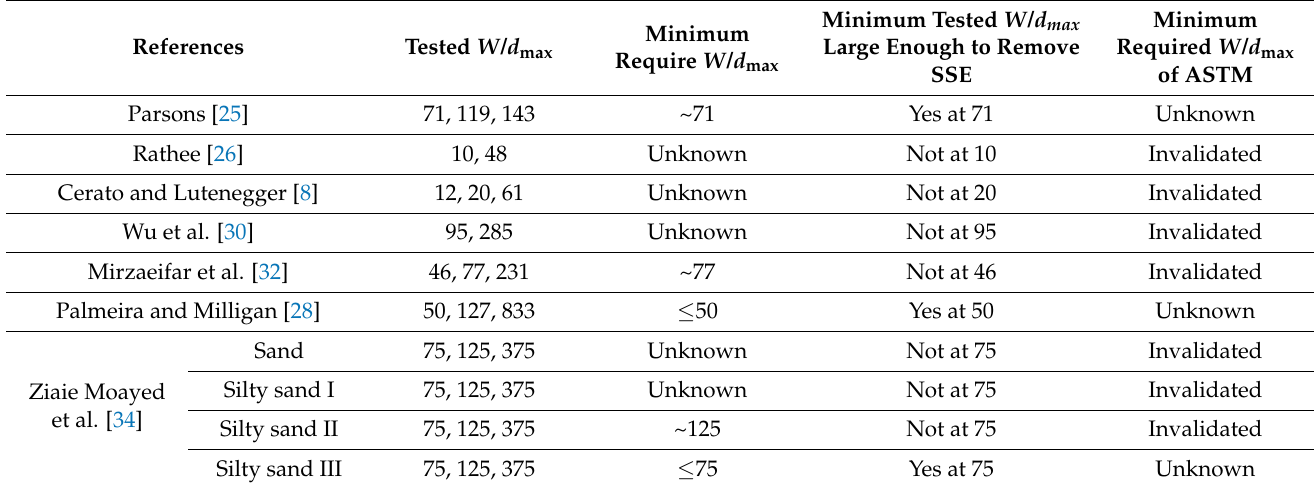
Table 8. Summarization of the analyses on existing test data obtained to investigate the